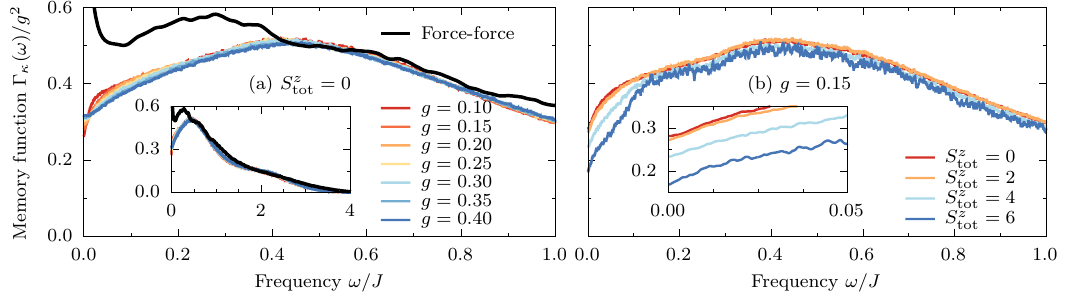
Figure 4: Energy-current memory function (relaxation-rate), Γ κ ( ω ) , (a) extracted = 0 with different perturbations g = 0.1 − 0.4, compared directly from ˜ C κ ( ω ) for S z tot with the perturbation result, Eqs. (8),(9), and (b) extracted for various S z ( ω ) for fixed g = 0.15. Calculated for L = 28 and ∆ = ˜ C κ